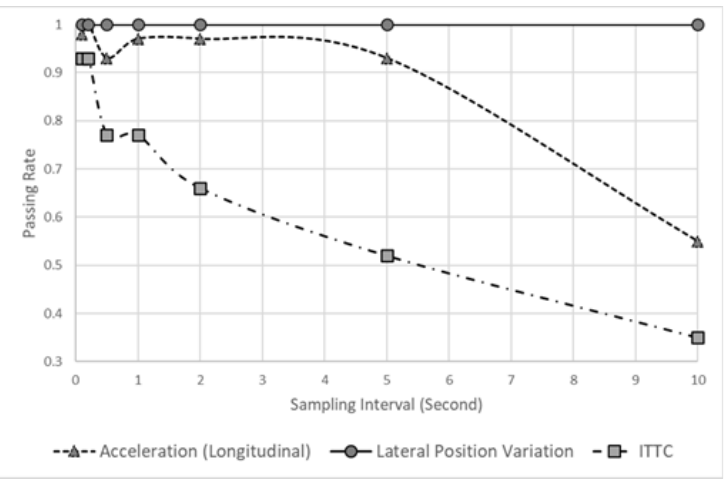
Figure 5. Passing rate of a hypothesis varying sampling